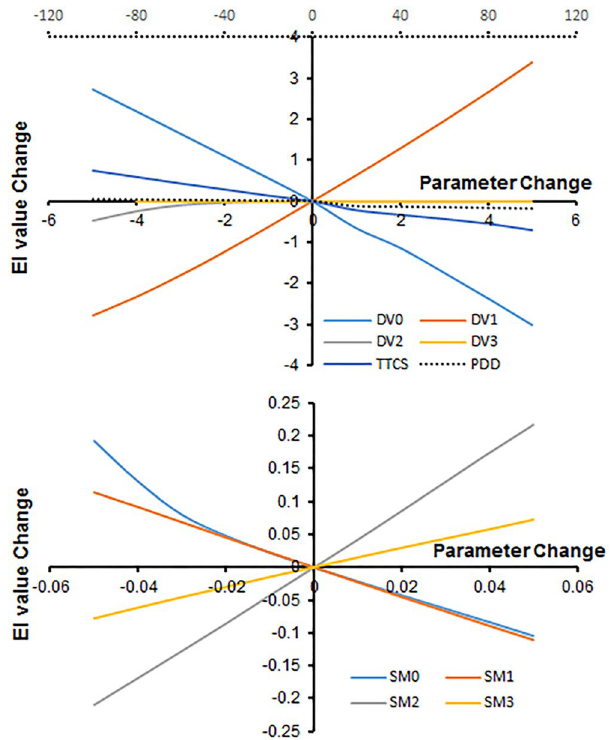
Figure 1. Sensitivity analysis of the selected parameters in CLIMEX for Euwallacea fornicates as change in average EI value. The dotted abscissa axis was applied for PDD. (DV0-Lower temperature threshold, DV1- Lower optimum temperature, DV2-Upper optimum temperature, DV3-Upper temperature threshold, TTCS-Cold stress temperature threshold, PDD-Effective accumulated temperature, SM0-Lower soil moisture threshold, SM1-Lower optimal soil moisture, SM2-Upper optimal soil moisture, SM3-Upper soil moisture